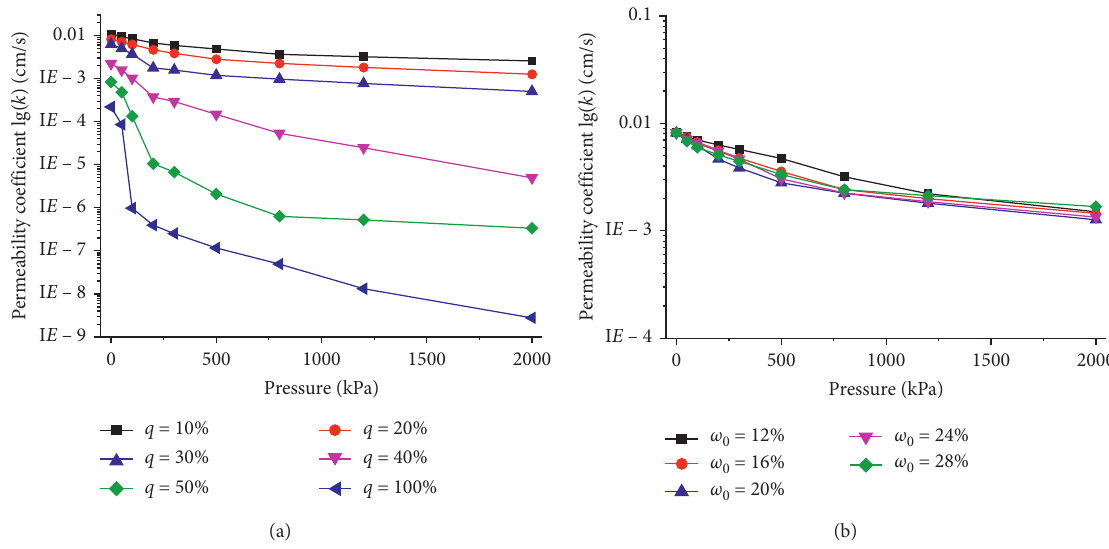
Figure 13: Relationship between permeability coefficient of sand and grouting pressure. (a) At different clay contents. (b) At different initial water ratios.